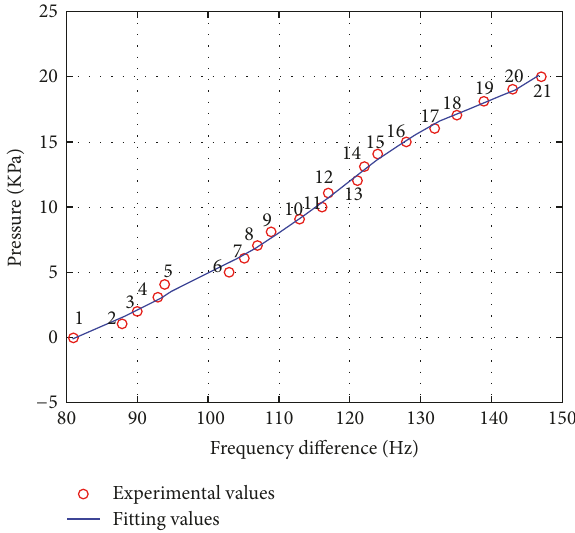
Figure 7: Fitting curve of the frequency difference and pressure of a SAW based on a micro force